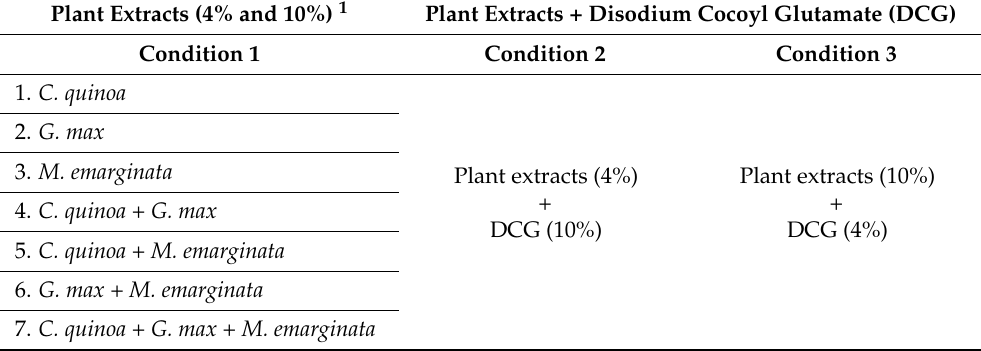
Table 2. Concentrations and combinations of plant extracts to determine the primary and secondary surfactants in